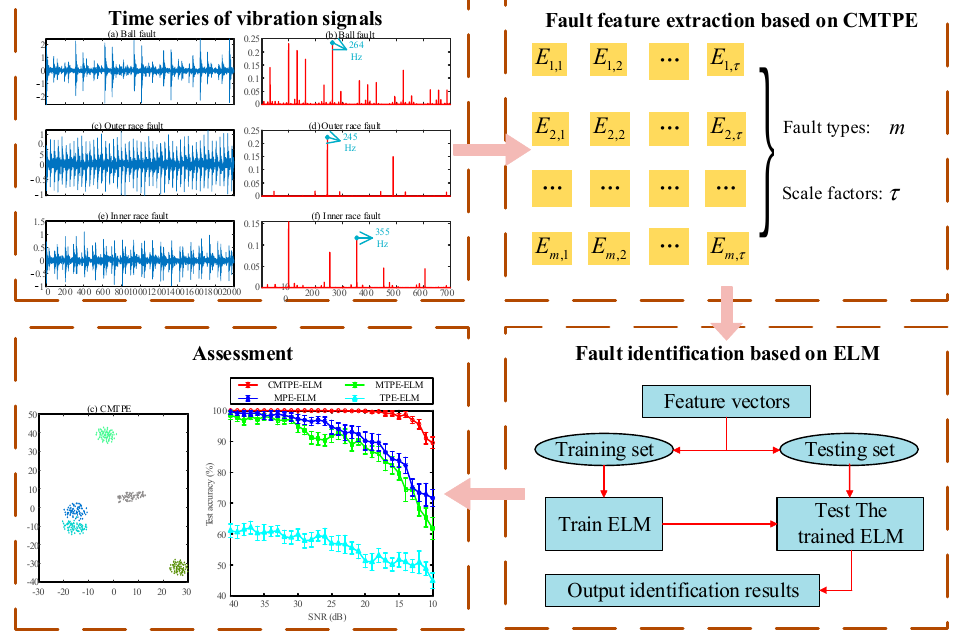
Figure 2. The overall fault diagnosis